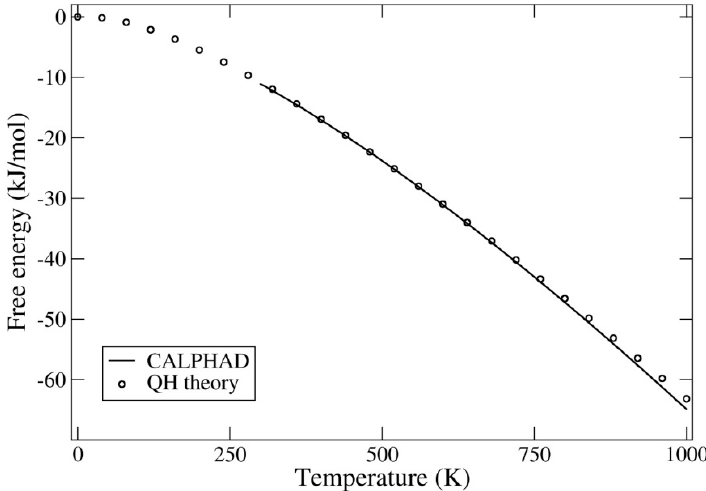
Figure 2. Gibbs free energies (kJ / mol) calculated from density-functional theory (DFT) and Debye–Grüneisen quasi-harmonic (QH) theory together with results from the SSUB6 calculation of phase diagram (CALPHAD) database.